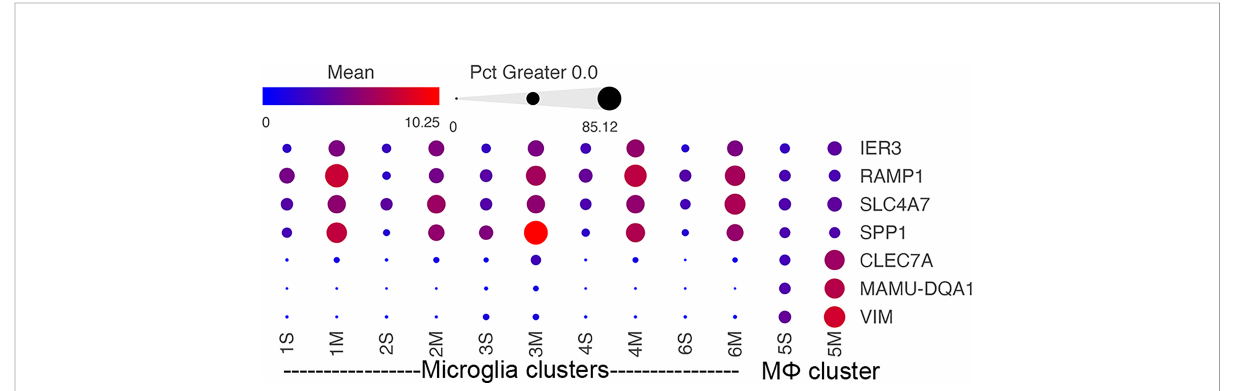
FIGURE 5 Morphine-related DEGs expression in the different clusters. Bubble plot of selected DEGs between the saline and morphine cells within the clusters. The color indicates the least-square mean expression (log 2 ), and the size of the circle indicates the percentage of cells in which gene expression was detected.